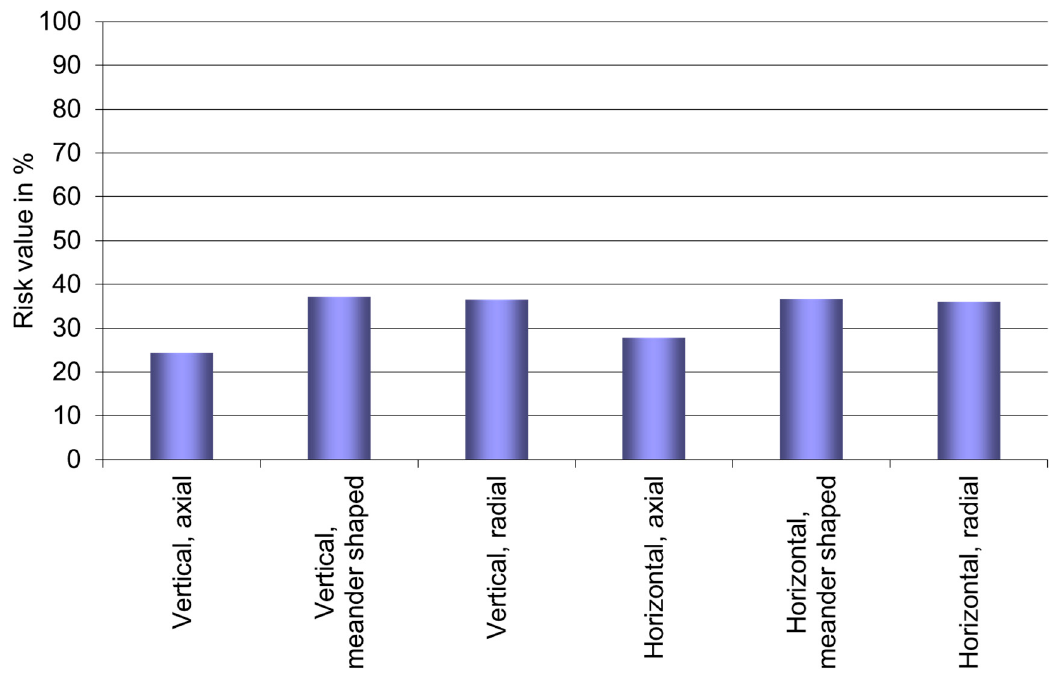
Table 5. Criteria for risk analysis and damage factors.